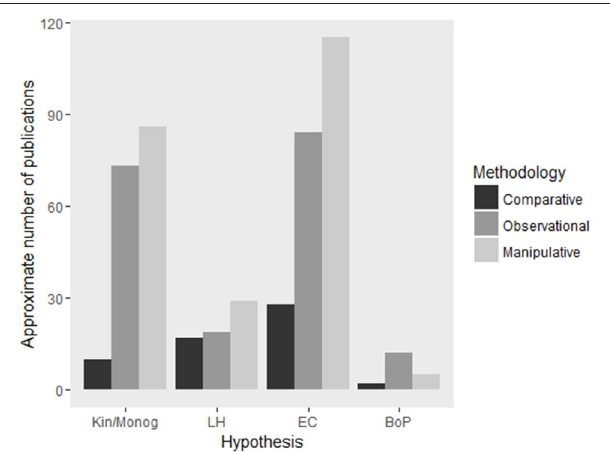
FIGURE 2 | Approximate number of articles published on each of the major hypotheses using comparative, observational and experimental methodologies. Abbreviations are: Kin, Kinship; Monog, Monogamy; LH, Life-history; EC, Ecological Constraints; BoP, Benefits of Philopatry. Search parameters are available in Supplementary Table S1. Numbers presented here are intended as approximations only as search parameters were not completely mutually exclusive or